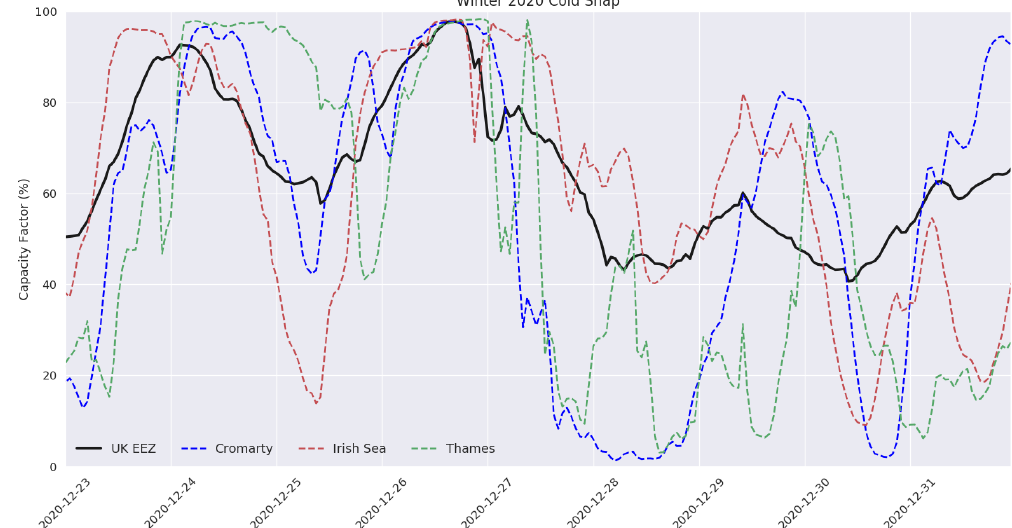
Figure 6. Case study of a period of variable capacity factors showing national time series of GB offshore wind power capacity factor (black) and three sub-regions containing a large proportion of UK offshore wind: Cromarty (blue; 0.7GW), Irish Sea (red; 1.7GW), and Thames (Green; 2.3GW).